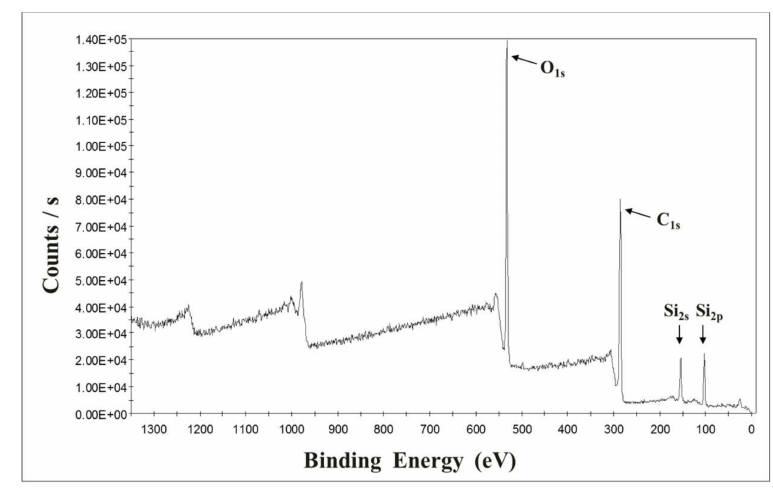
Figure 7. XPS spectra of untreated wood flour.